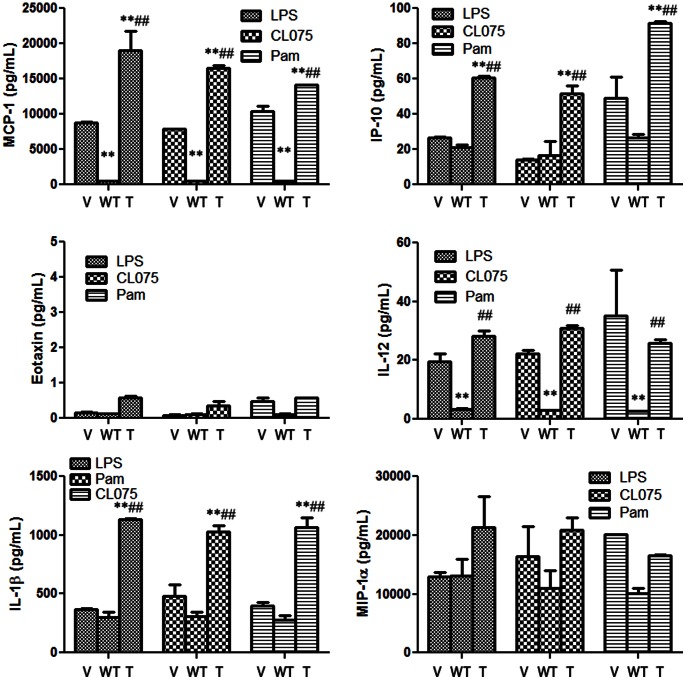
Cytokine secretion of TLR-ligand-treated monocytes transfected with wild type or mutated C11orf40 gene.Human monocytes were transfected with empty vector (V),wild type C11orf40 (WT) or the W32X truncated mutant gene (T) and challenged with three TLR ligands, LPS (TLR4), CL075 (TLR7/8), and Pam3CSK (TLR 1/2), followed by measurement of secreted cytokine 24 hrs. later. P values are for comparison to vector control (**, P = 0.005) or WT (##, P = 0.005).